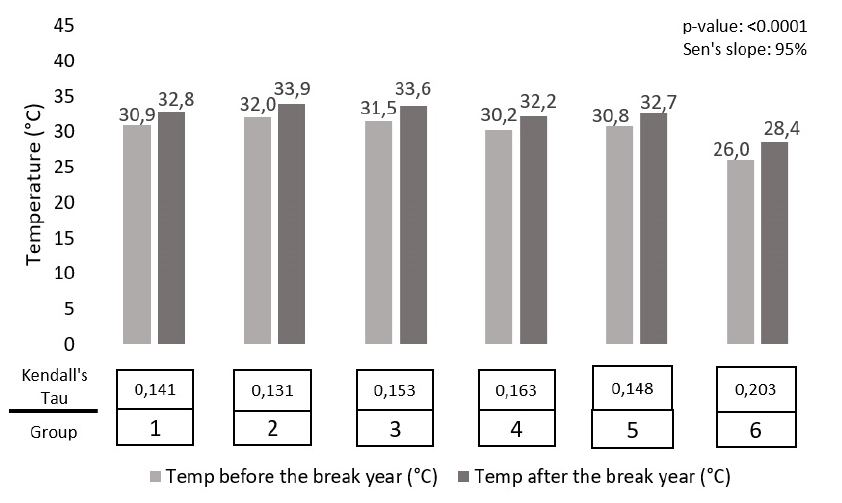
Figure 5. Mann-Kendall test and Pettitt test values for maximum temperature (months of September and